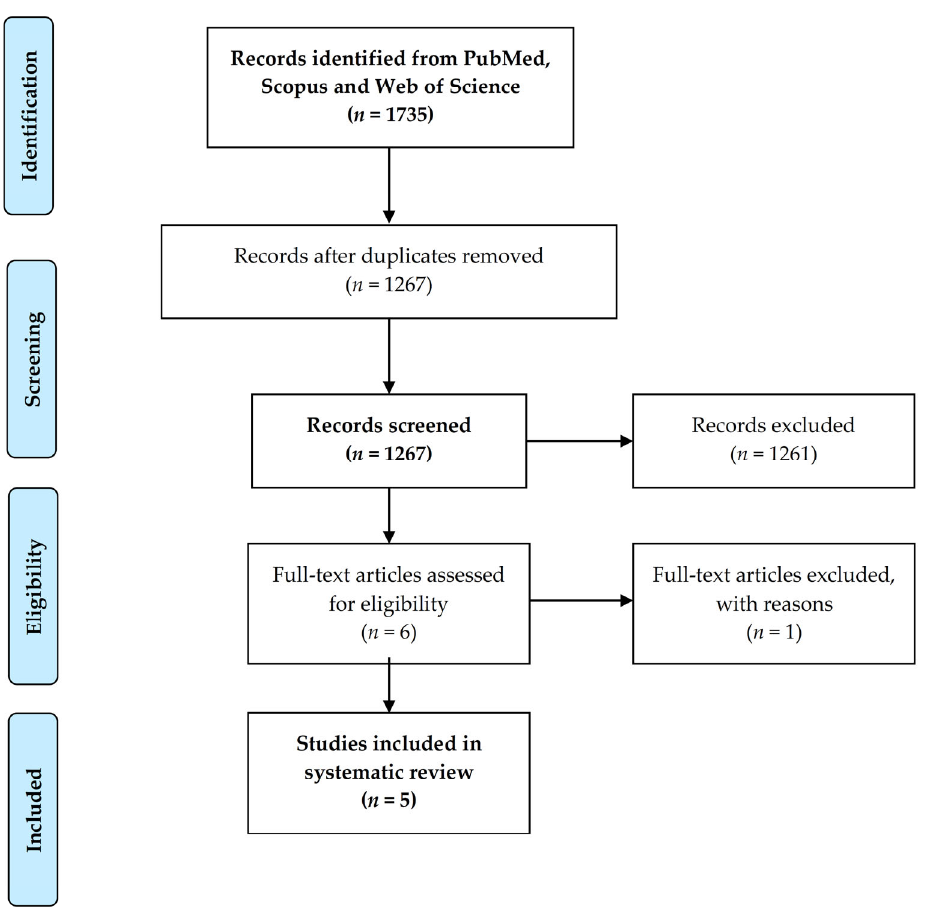
Figure 1. PRISMA flowchart illustrating the process of study selection.